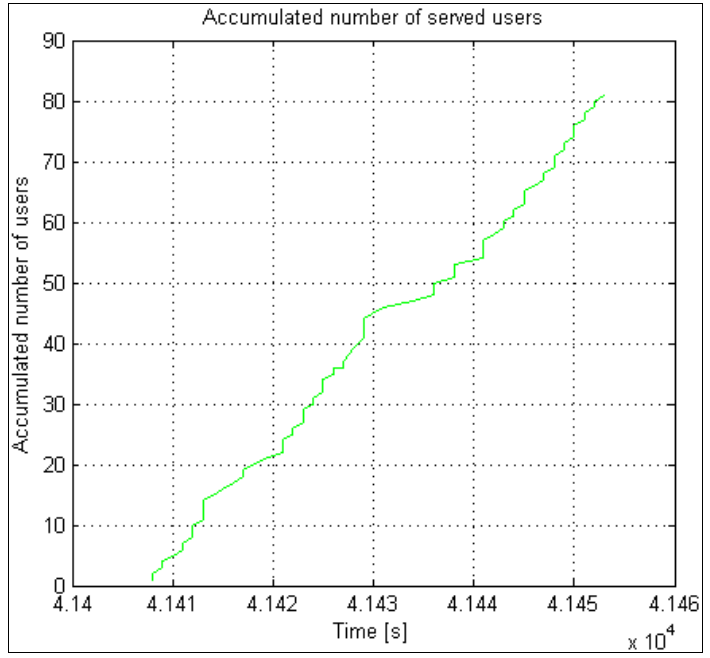
Figure 23. Accumulated number of served users during the observation period. U = 81, P = 15. Table 7. The results of searching for an optimal number of service capacities for an increased user quota U = 81 with the proposed